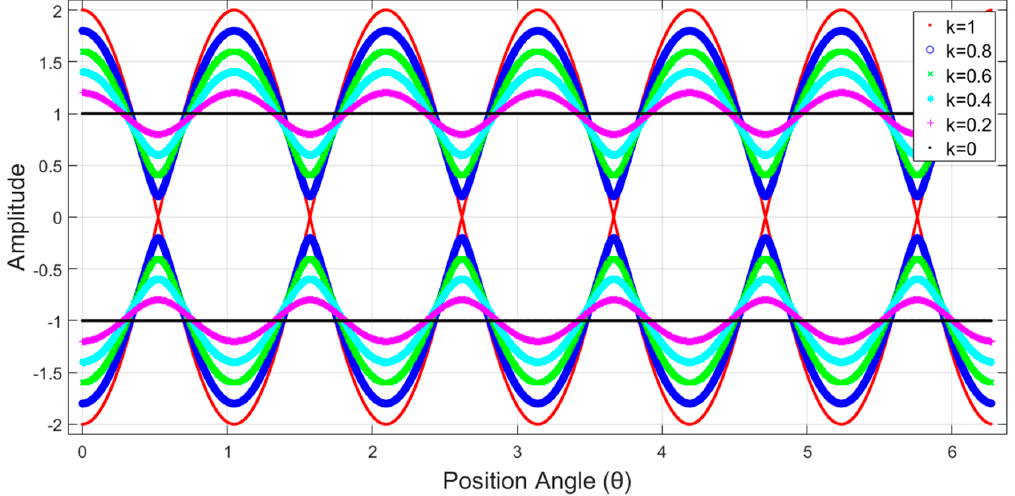
Figure 2. Envelope line of different 𝑘 (cid:3028)(cid:3040)(cid:3043) values.